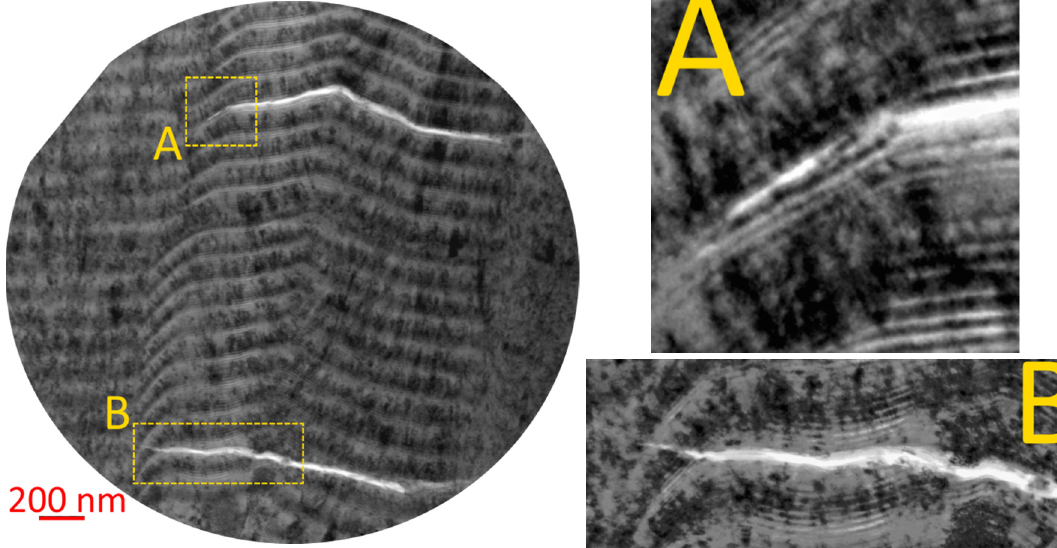
Figure 10. Pattern of the formation of longitudinal cracks and delaminations in the Ti-TiN- (Ti,Cr,Mo,Al)N coating on the rake face of the tool (TEM). ( A ) inter nanolayer delamination ( B ) nanolayer cut by a